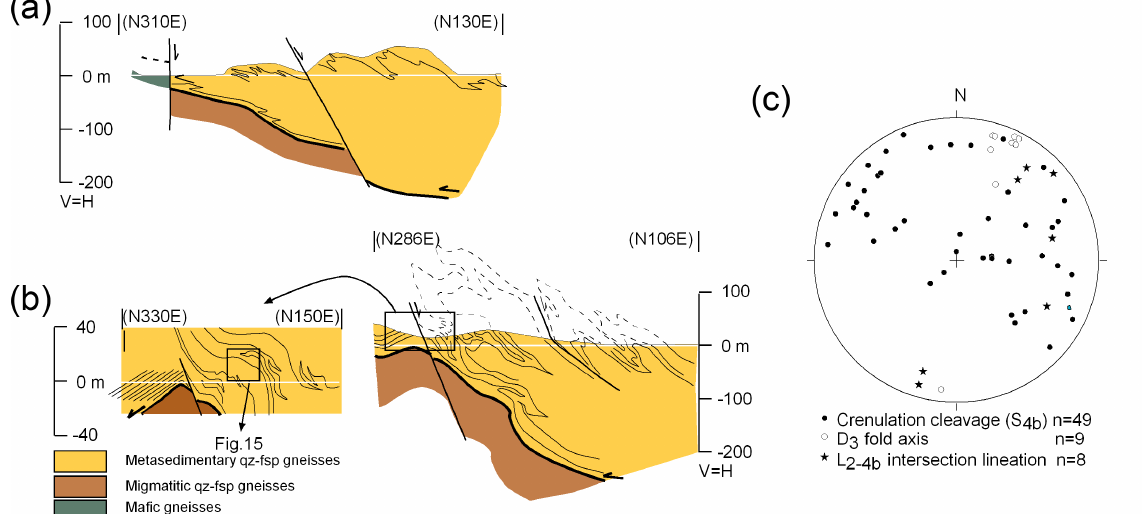
Figure 14. Geological sections of the D 3 -recumbent syncline reconstructed from the small-scale parasitic folds that are folding the main S 2 foliation. Location of the sections is in Fig. 2a. White lines represent the sea level. (a) Northern outcrop section. (b) Southern outcrop section and the structural detail with location of Fig. 15. Note that the recumbent synform is affected by open-upright D 4 b -folds. (c) Crenulation cleavage S 4 b , D 3 fold axes and L 2 − 4 b intersection lineation is plotted in an equal area, lower hemisphere projection.